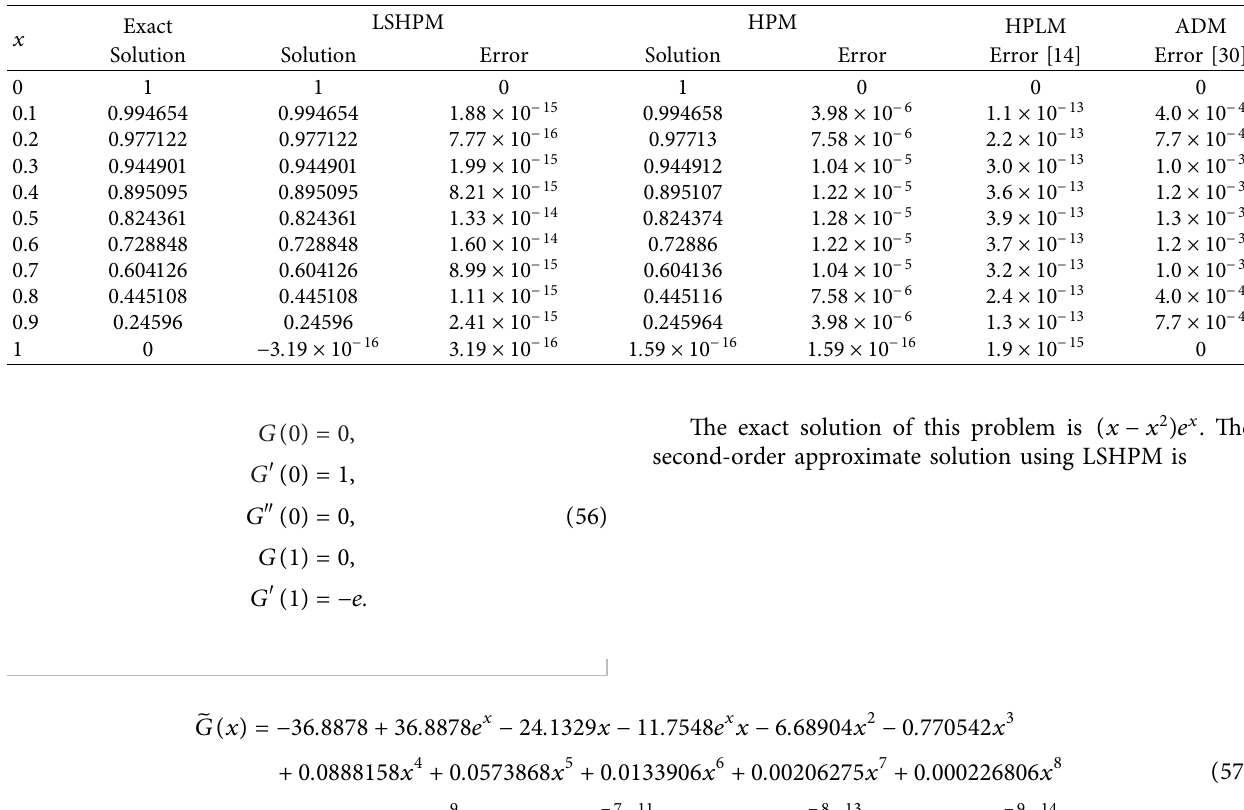
Table 9: Comparison of first-order absolute error of LSHPM with second-order HPM, HPLM, and ADM in Problem